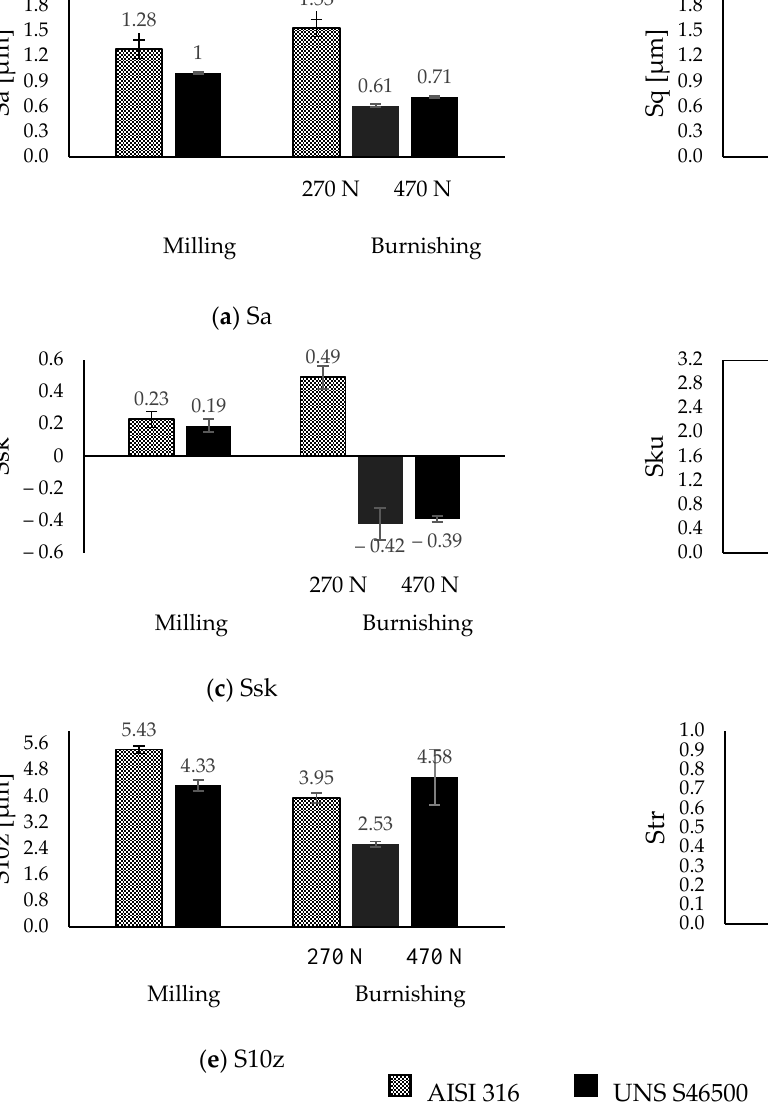
Figure 6. Textured surfaces after milling and burnishing processes at different contact pressures. Based on the height parameters Sa and Sq, a normal distribution of heights (Sa = 0.8 Sq) was evidenced under milling conditions for both materials. This observation was corroborated by the skewness values (Ssk ~ 0) under the same milling conditions. This tendency varied after ball burnishing. Thus, under the same load conditions, the statistical asymmetry after burnishing on AISI 316 stainless steel showed a mass distribution skewed to below the mean plane (Ssk > 0), while the surface of UNS S46500 stainless steel is skewed to above the main plane (Ssk < 0) in equal proportion. The load increment on the second one slightly varied under this condition. With regard to kurtosis (Sku ~ 3), it was observed that the austenitic surface became a non-abrupt platykurtic condition, whereas the martensitic surface responded with a better fit to a Gaussian distribution despite the load increase. The S10z parameter provides a practical criterion for the statistical behavior of the height. It reveals that the five-point peak height and five-point pit height were 20% more prominent on the austenitic surface. However, this was reduced by 36% on